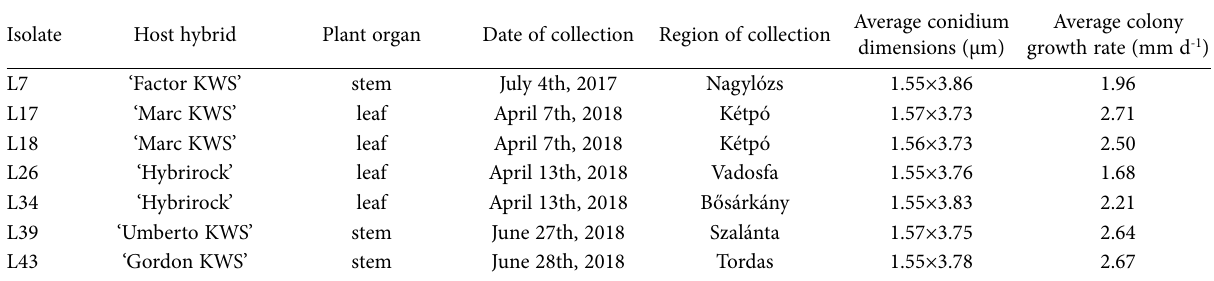
Table 1. Host and plant organ sources, collection dates and regions of Hungary, average conidium dimensions and colony growth rates, for representative Plenodomus isolates assessed in this study.